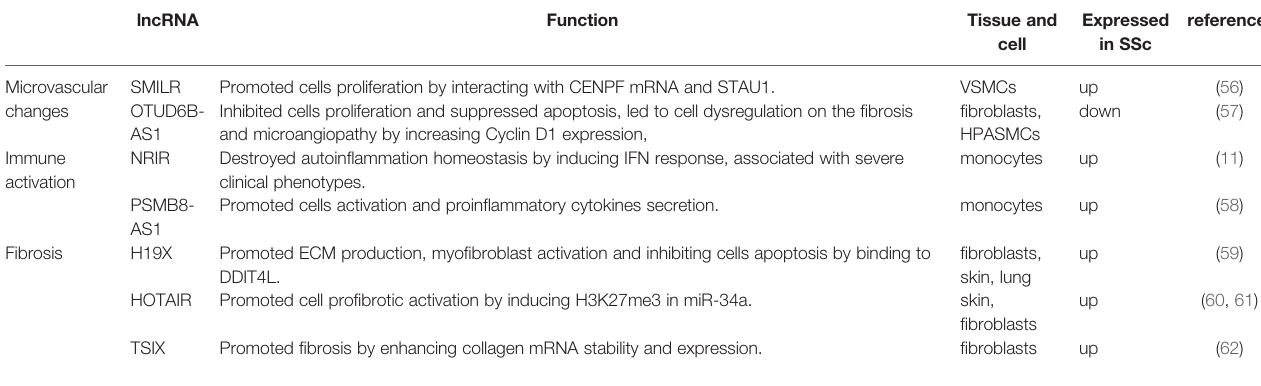
TABLE 2 | The Role of lncRNAs in SSc. lncRNA Function Tissue and